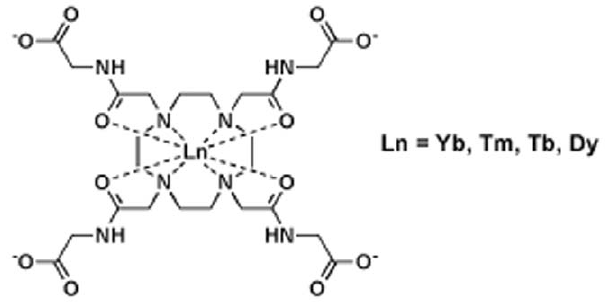
Figure 1. Molecular structure of LnDOTA-tetraglycinate (LnDOTA-(gly) 4 2 where Ln refers to the indicated lanthani- de(III) ions).